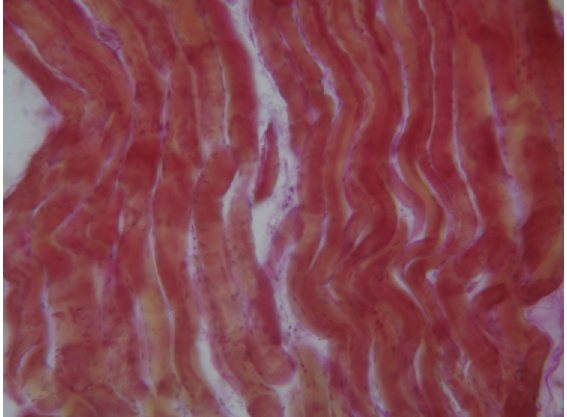
Figure 5. Microstructure of a lip tissue sample after processing with the ferment preparation Protepsin, magn. 200. (after 2